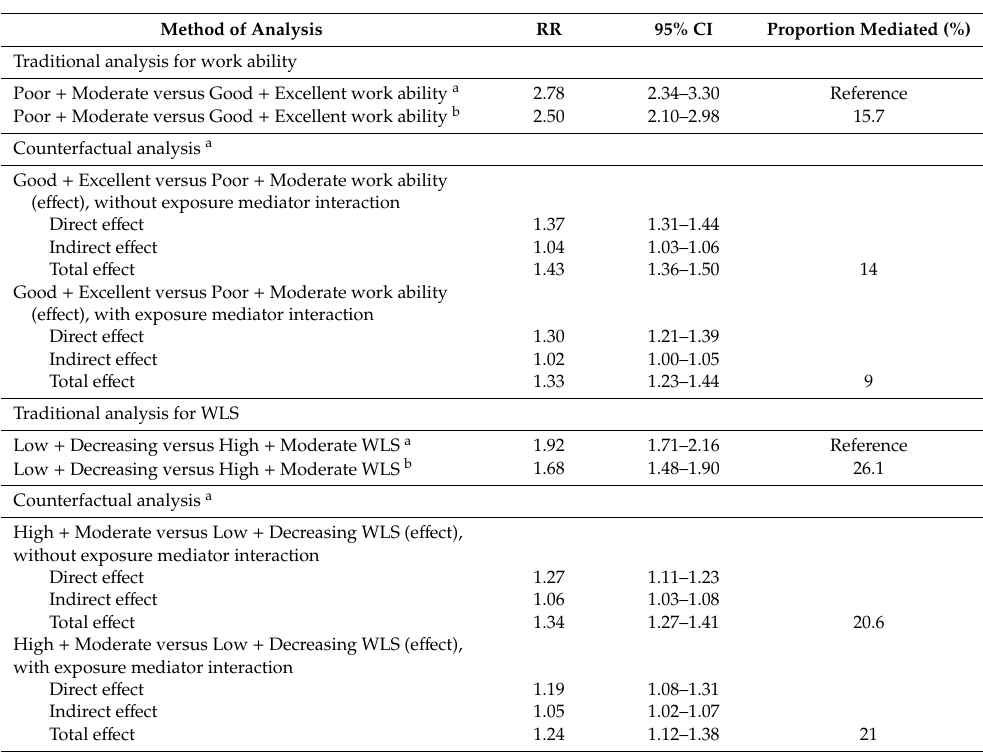
Table 5. Risk Ratio (RR) and 95% CI on the association between exposures (work ability and satisfaction in work life (WLS)) and outcome (intention to retire) with Job support as the